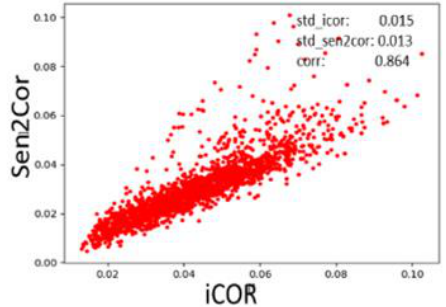
Figure 6. Scatterplot for Sen2Cor and iCOR in forest area.